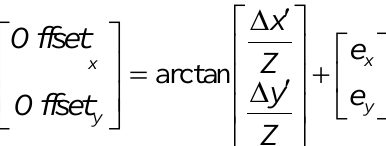
Figure 9. Analysis of Angle